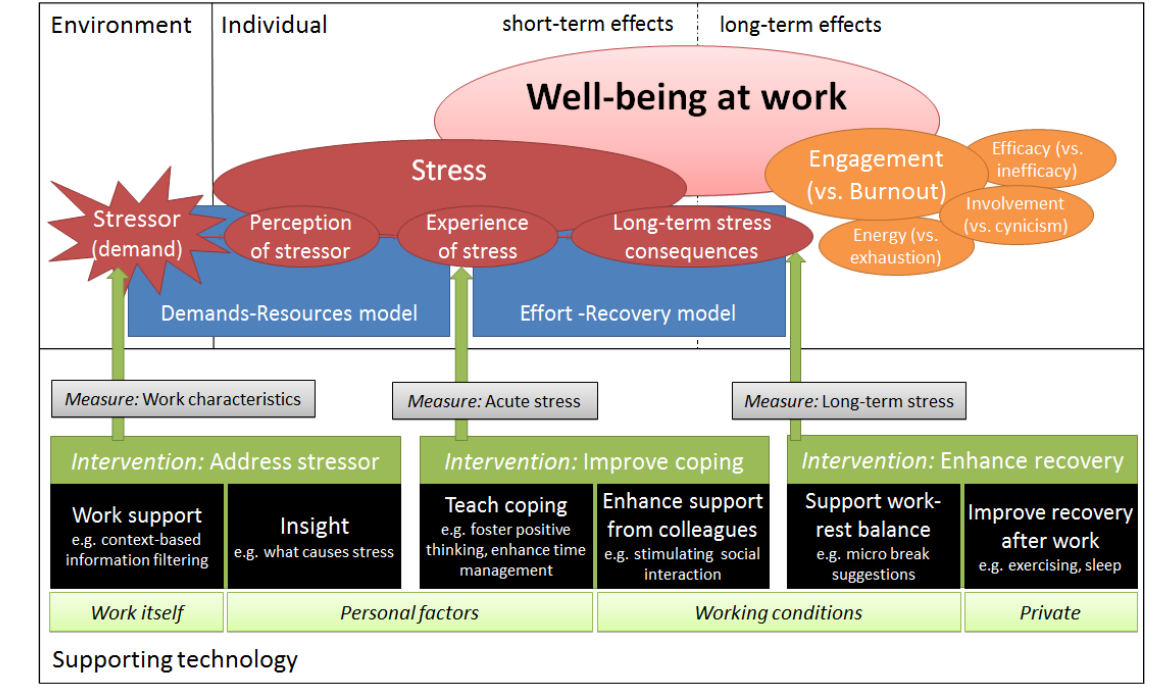
Figure 2. Our framework that combines various stress and intervention theories, as well as possibilities for real-time measurements and interventions with